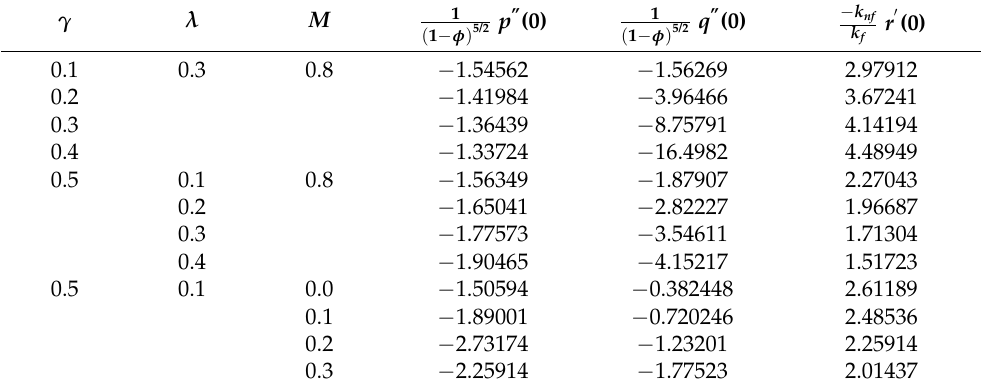
(cid:0) (cid:1) Cf x , Cf y and Nusselt number ( Nu )